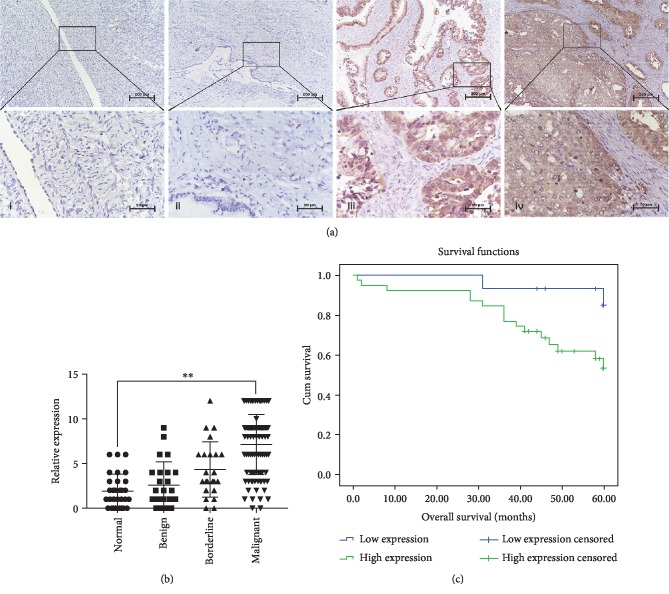
The expression of BMPER protein in different ovarian tissues and its effect on overall survival of ovarian cancer patients. (a) BMPER protein expression in different ovarian tissues (SP, 100×; bottom: 400×) (n = 171). The ovarian tissues of each group were serially sectioned at 5 μm, and BMPER expression was detected by the immunohistochemical SP method. All sections were scored under a light microscope in five randomly selected fields at 400× magnification. (i) Normal ovarian tissue (n = 30); (ii) ovarian benign tumor (n = 24); (iii) ovarian borderline tumor (n = 23); and (iv) ovarian epithelial malignant tumor (n = 94). (b) Statistical analysis of the results in (a). (∗∗P < 0.01). (c) Kaplan-Meier survival analysis showed the influence of BMPER expression on the overall survival of ovarian cancer patients; log-rank test P = 0.013 for BMPER expression in overall survival (n = 94).